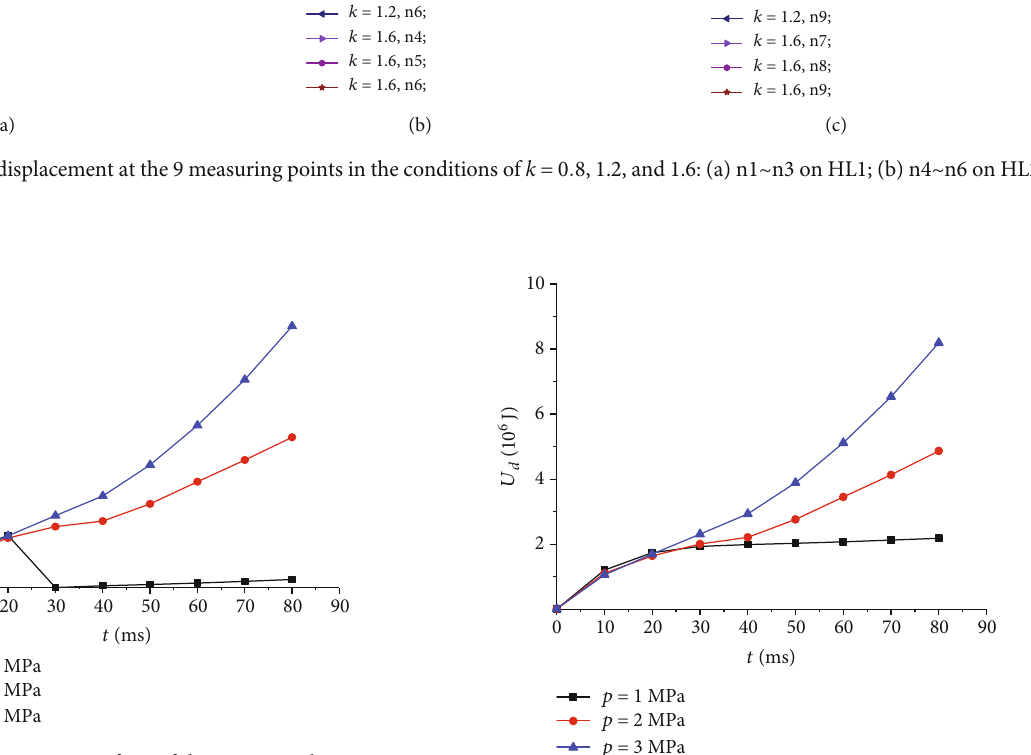
Figure 10: The evolution process of U and 3MPa. Figure 11: The evolution process of U